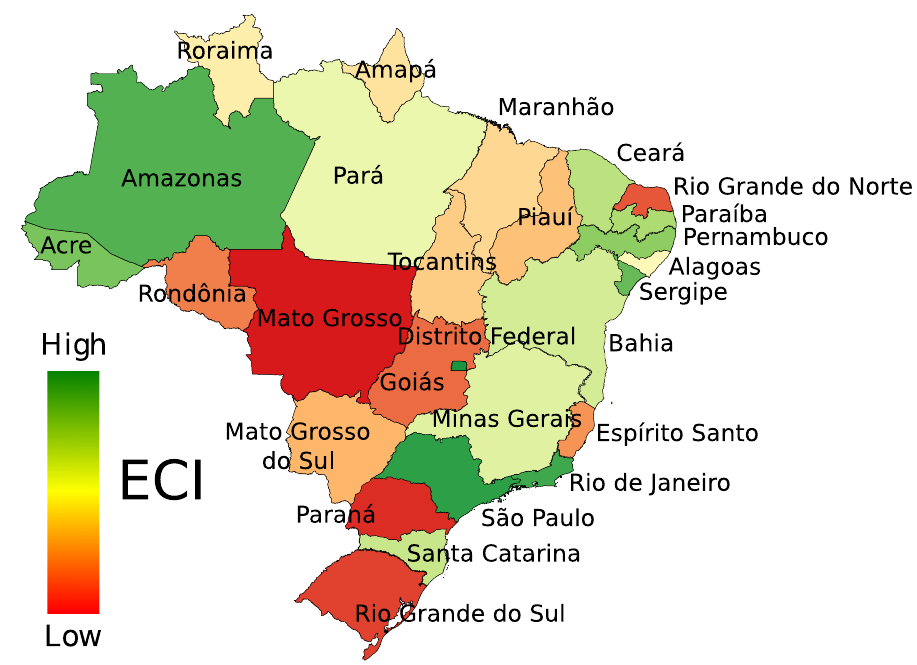
Fig 11. ECI map of the Brazilian states. The colors in the map vary from green (high ECI) to red (low ECI) and they show the variation of the ECI across the Brazilian states.